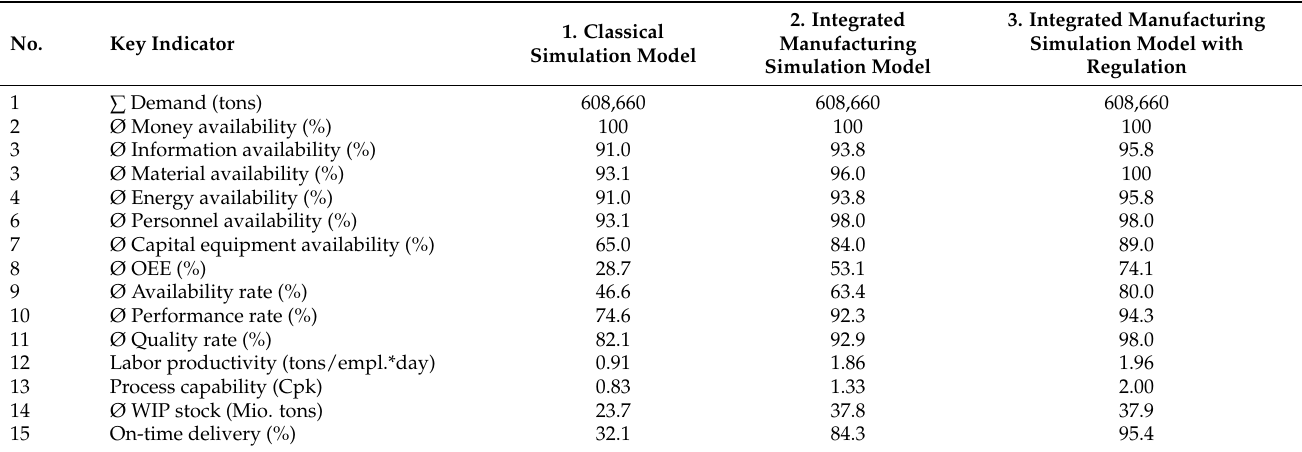
Table 2. Simulation results.